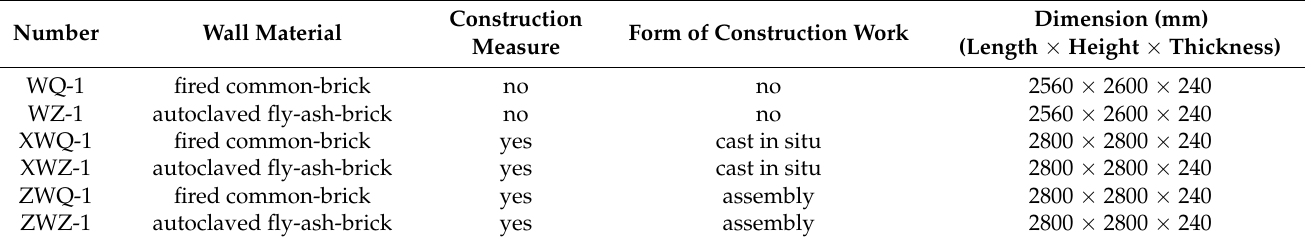
Table 4. Dimensions and parameters of the walls.